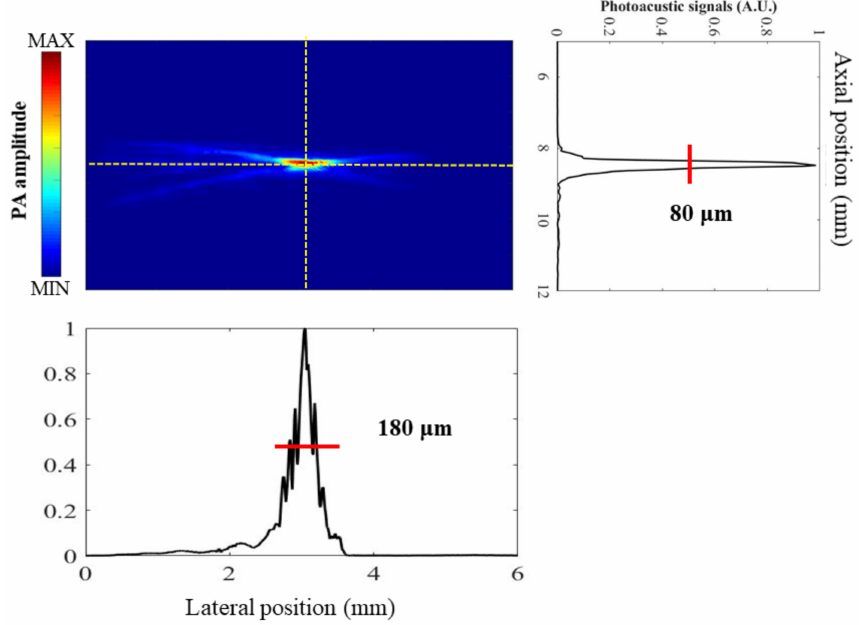
Figure 5. Measurement of axial and lateral resolutions using a 6 µ m carbon fiber tube. An axial resolution of 80 ± 5 µ m and a lateral resolution of 180 ± 32 µ m were